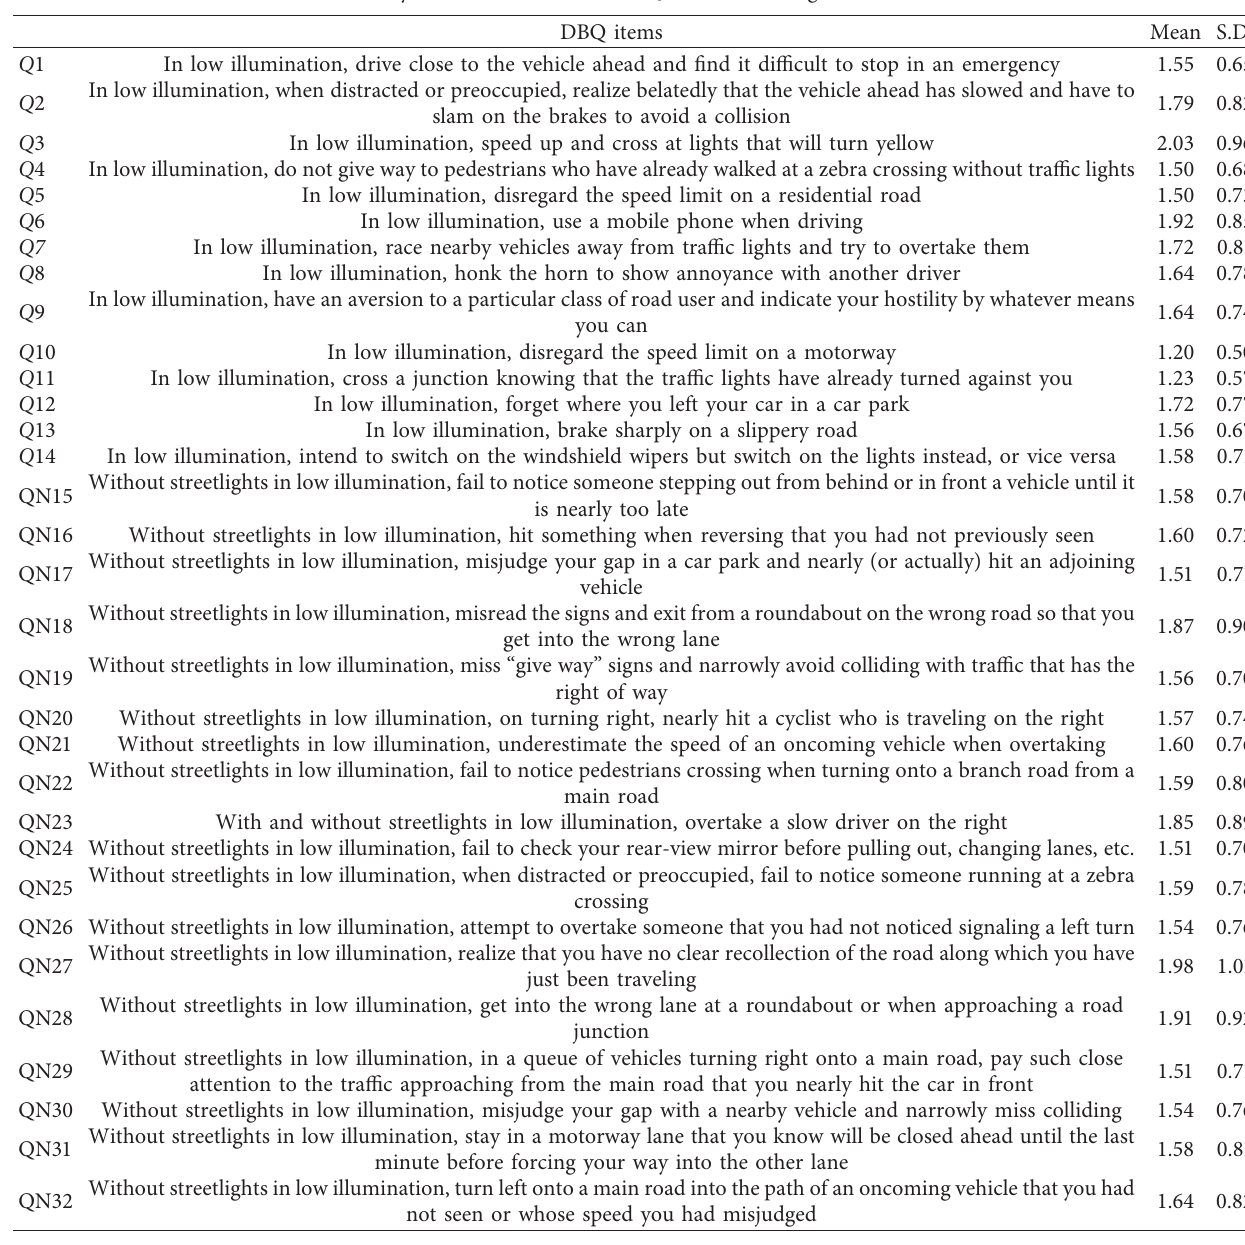
Table 2: Summary of the results for the DBQ without streetlights in low